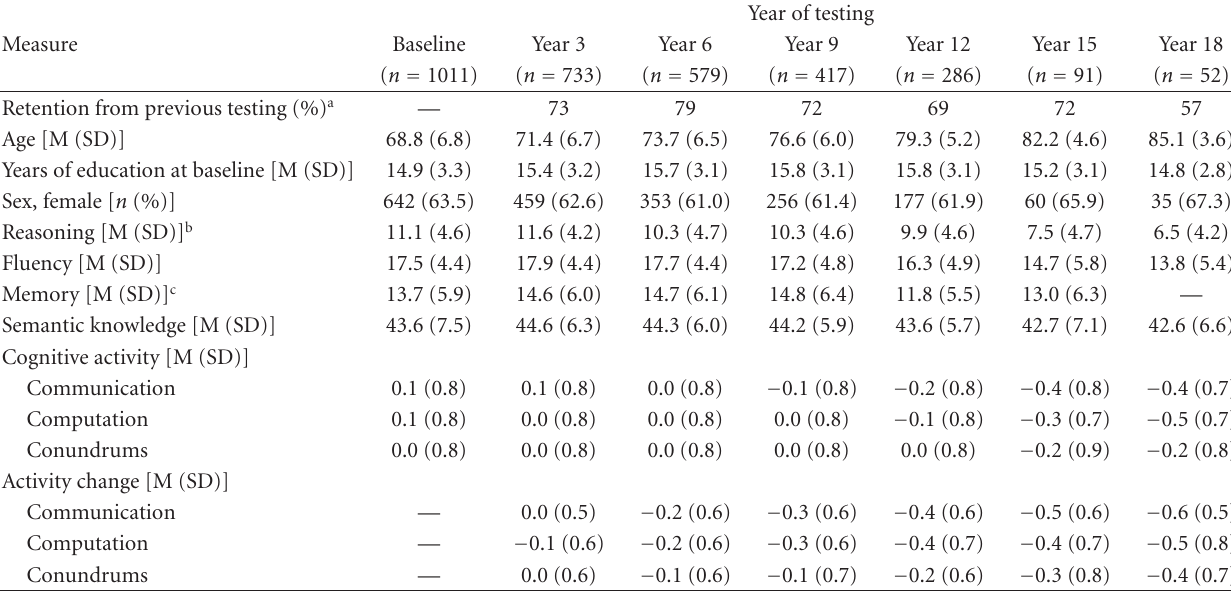
Table 4: VLS participant